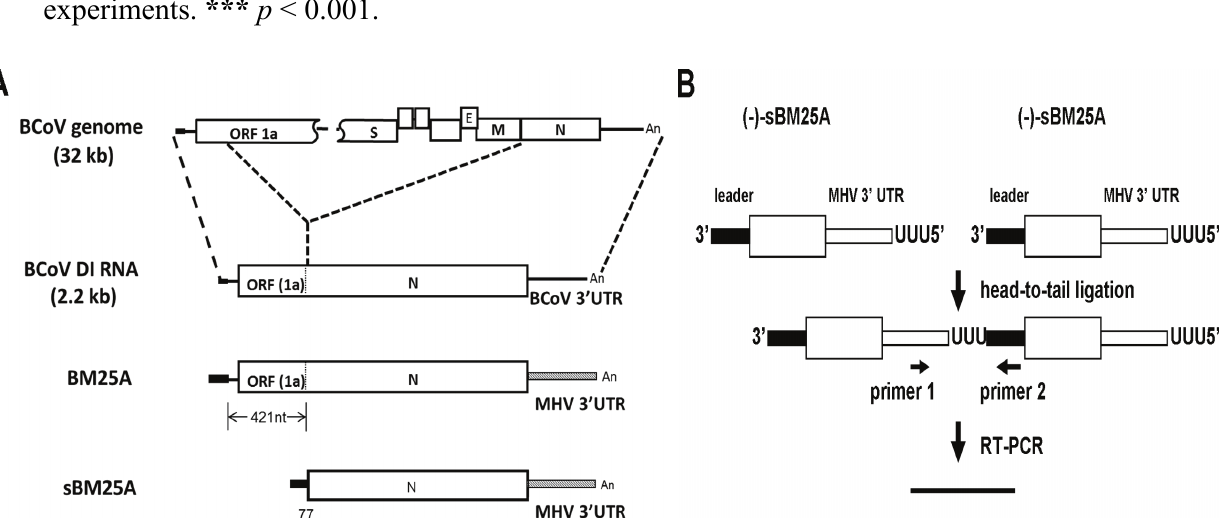
Figure 1. Comparison of the efficiency of the ( − )-strand RNA synthesis between sgmRNA 7 and BCoV DI RNA with the strategy of head-to-tail ligation. ( A ) Upper panel: schematic diagram depicting the BCoV genome and BCoV DI RNA. Lower panel: constructs BM25A and sBM25Awith the 3' UTR of both constructs replaced with the MHV 3' UTR. ( B ) Strategy for detection of ( − )-strand sgmRNA with head-to-tail ligation. ( C ) RT-PCR product synthesized with the strategy described in Figure 1B. Lane 2, BM25A-transfected BCoV-infected cells; lane 3, sBM25A-transfected BCoV-infected cells; lane 4, mock-infected cells; lane 5, BCoV-infected and mock-transfected cells; lane 6, BM25A-transfected mock-infected cells; lane 7, sBM25A-transfected mock-infected cells; lane 8, a mixture of BCoV-infected cellular RNA extracted at 8 hpt and 200 ng of BM25A transcript; lane 9, a mixture of BCoV-infected cellular RNA extracted at 8 hpt and 200 ng of sBM25A transcript. RT-PCR was used to detect the potential recombination between the BCoV genome and BM25A (lane 12) or sBM25A (lane 13). A recombinant DNA of 1639 bp was produced to serve as a size marker (lane 14). M (lanes 1, 10 and 11), ds DNA size markers in nt pairs. ( D ) Left panel: the relative efficiency of ( − )-strand RNA synthesis from constructs BM25A and sBM25A, as measured by RT-qPCR. Control A: total cellular RNA from mock-infected cells. Control B: total cellular RNA from BCoV-infected cells. Control C: total cellular RNA from sBM25A-transfected mock-infected cells. Control D: a mixture of BCoV-infected cellular RNA extracted at 8 hpt and 200 ng of BM25A transcript. Right panel: measurements of reporter-containing RNA (BM25A and sBM25A), 18S rRNA and BCoV sgmRNAs at 8 hpt (VP0) by Northern blot assay. The values (D) represent the mean ± SD of three individual experiments. *** p <